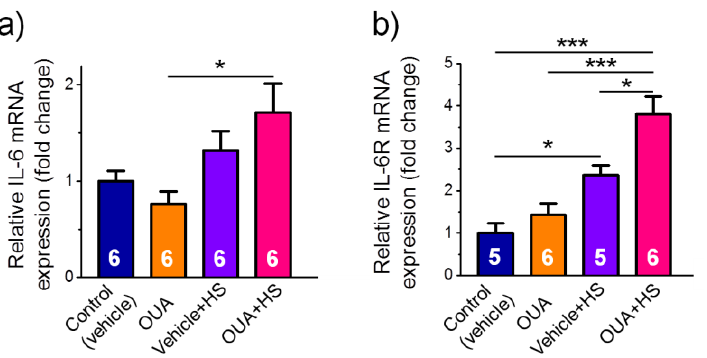
Figure 8. Pre-treatment with ouabain (1 μg/kg) for 4 days modulates mRNA expression of IL-6 ( a ) and IL-6R ( b ) after 6-h HS. Relative expression is shown. Control and ouabain-treated (OUA) groups are represented by the rats, which received injections of vehicle (0.9% NaCl) or ouabain for 4 days, respectively. HS group contains the rats injected by vehicle followed by HS for 6 h. OUA + HS group is a group of ouabain-injected rats that were exposed for the following 6 h HS. The number of rats n = 5–6, as indicated. Two-way ANOVA followed by Tukey’s multiple comparisons test. * p < 0.05, *** p < 0.001—compared as indicated by horizontal bars.